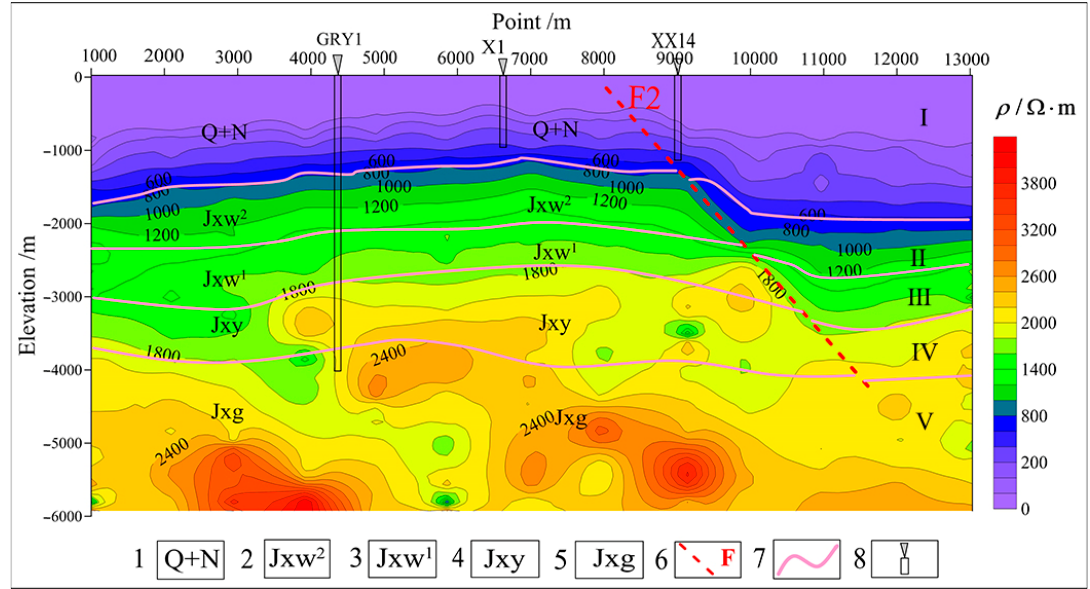
Figure 4. Integrated MT interpretation of a section of survey line L2 (refer to Figure 3 for an explanation of the symbols).